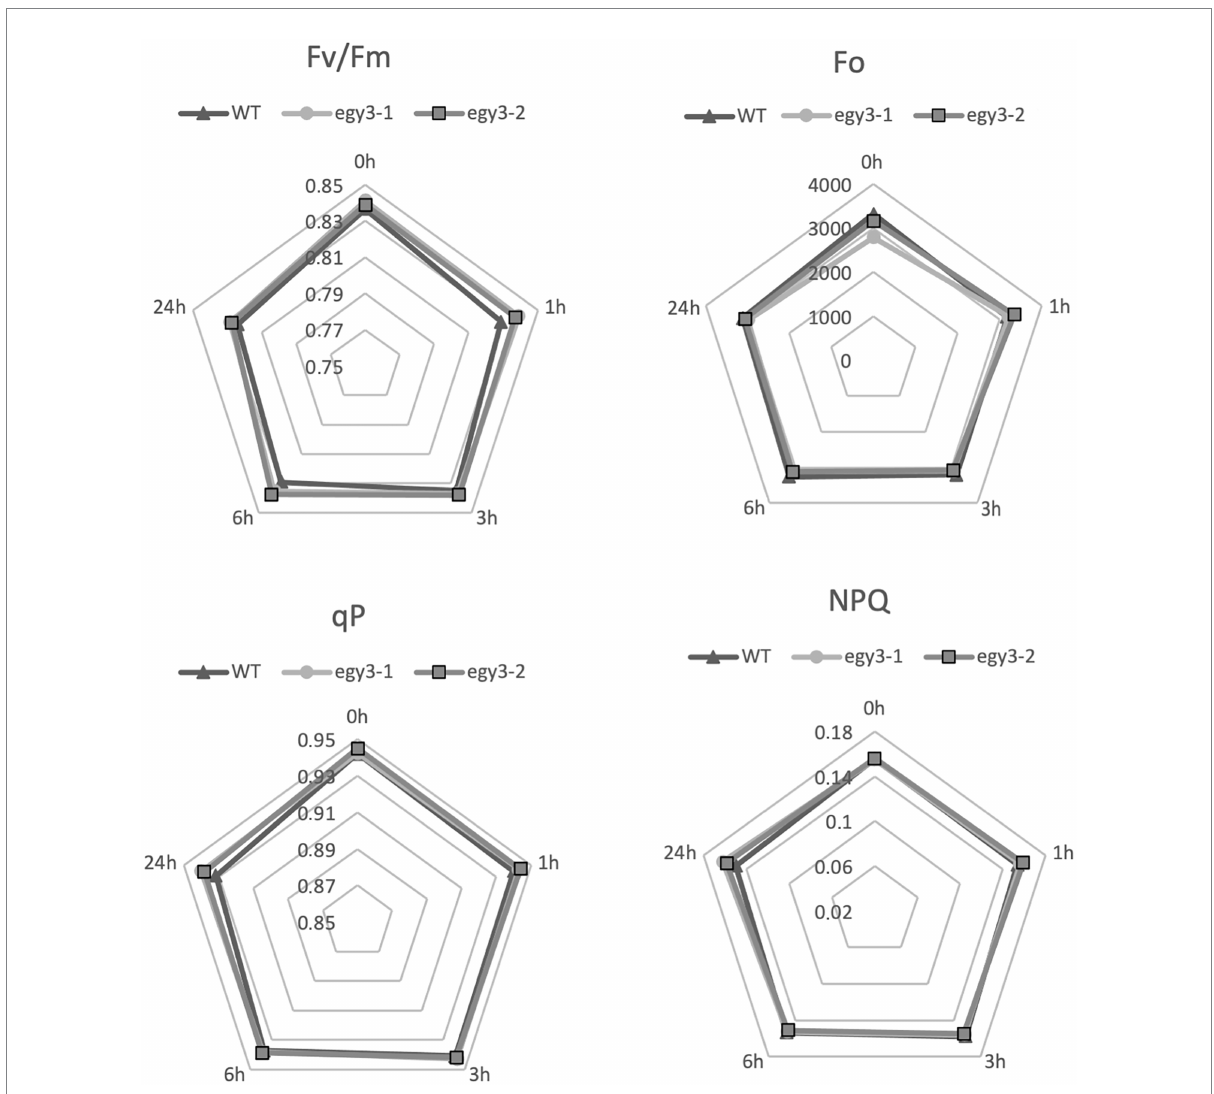
FIGURE 10 Comparison of chlorophyll fluorescence parameters in wild-type (WT) plants and egy3 mutants during exposition to high-temperature stress. The presented values are average from three biological replicates (10 plants